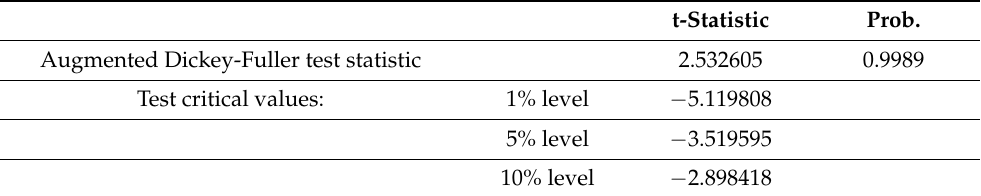
Table 12. Augmented Dickey-Fuller Unit Root Test on the number of FinTech companies.